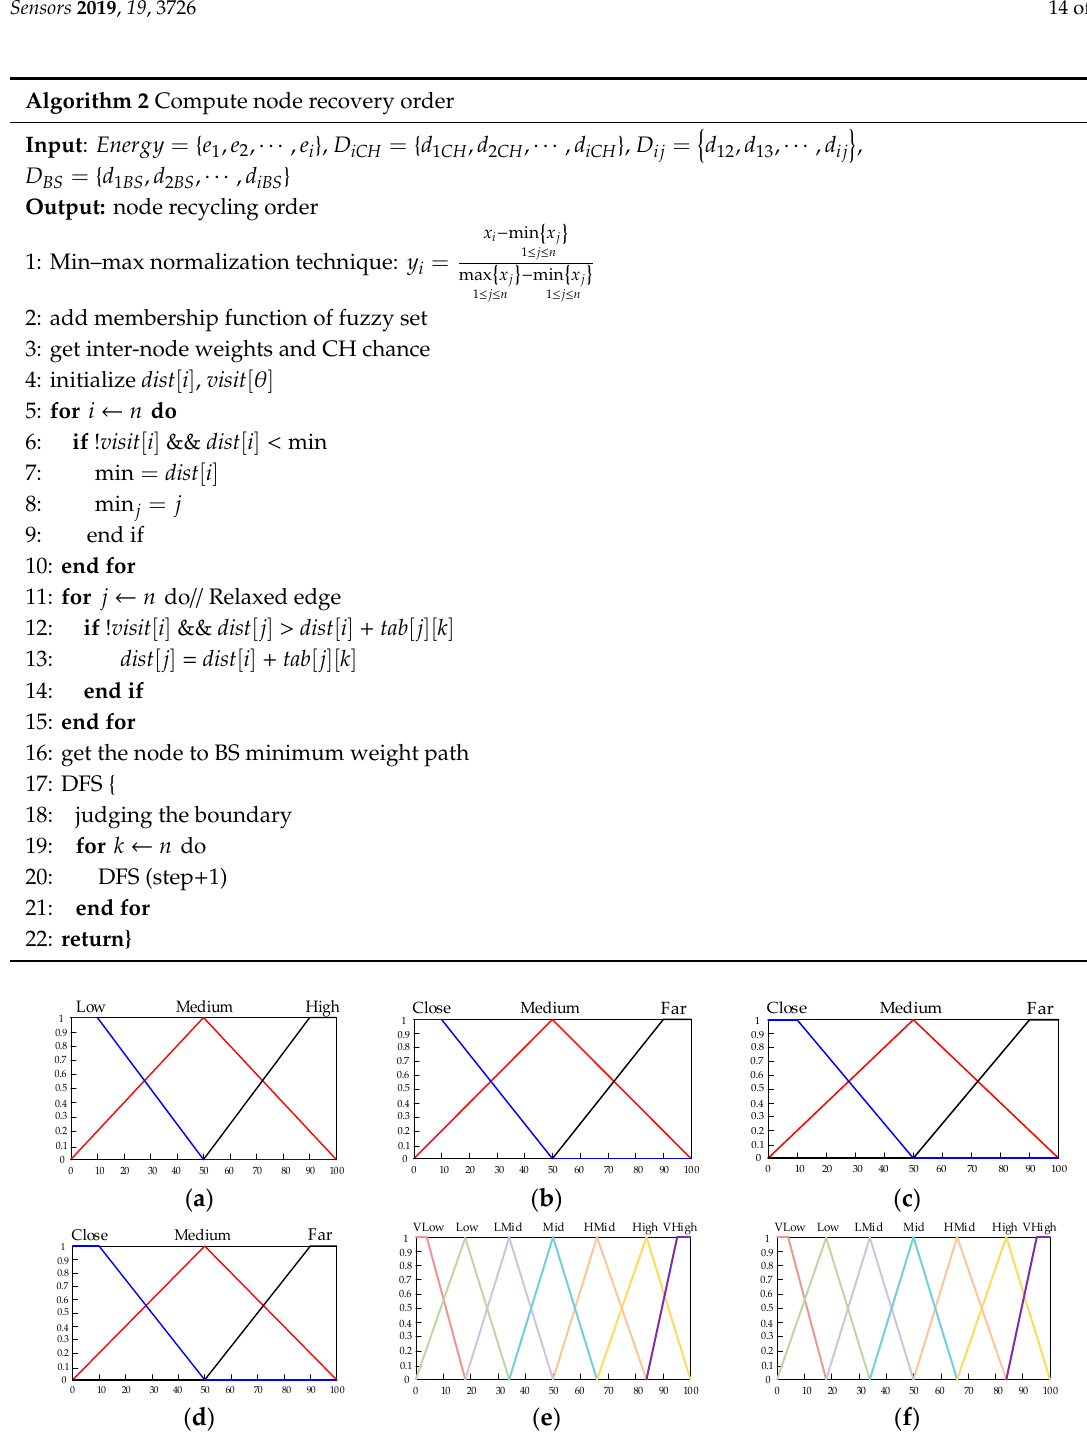
Figure 6. Membership functions of the fuzzy sets. ( a ) Energy; ( b ) D iCH ; ( c ) D ij ; ( d ) D BS ; ( e ) fuzzy output variable weight; ( f ) fuzzy output variable CH.